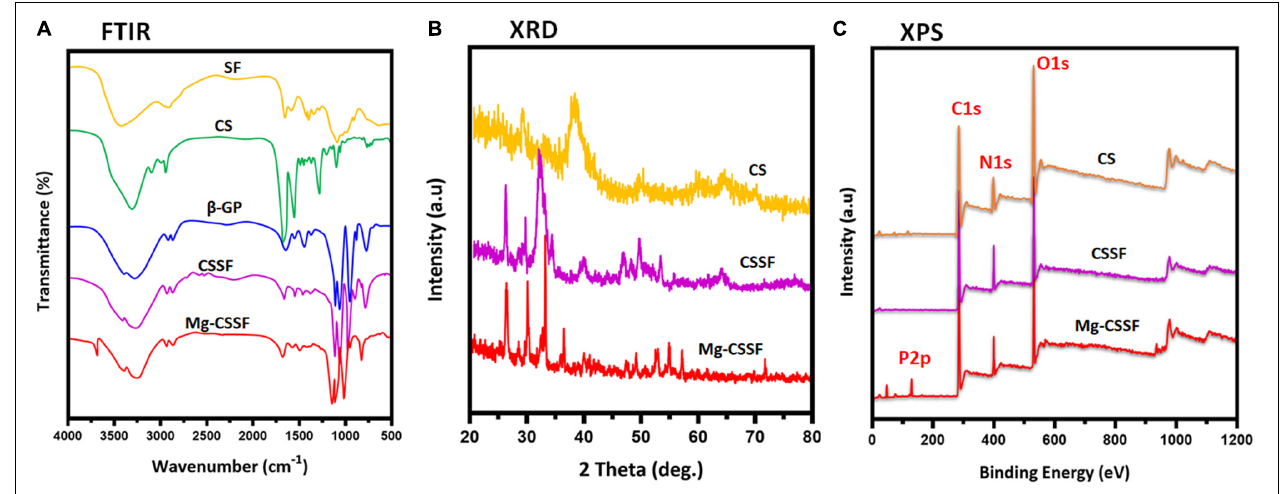
FIGURE 2 | Structural interactions, chemical compositions, and elemental distributions were evaluated by spectroscopic methods of Fourier transform infrared (FTIR) (A) , x-ray diffraction (XRD) (B) , and XPS (C) analyses.